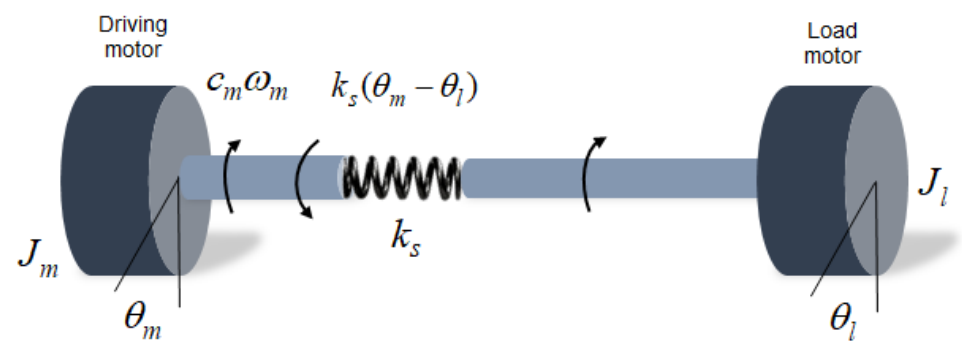
Figure 2. Schematic of the rotating shaft model with shaft torsional stiffness. The four state variables for stiffness estimation are selected as shown in Equation